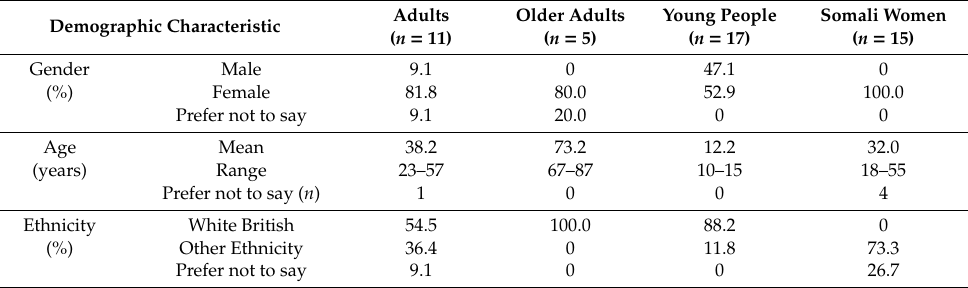
Table 1. Demographic characteristics of workshop